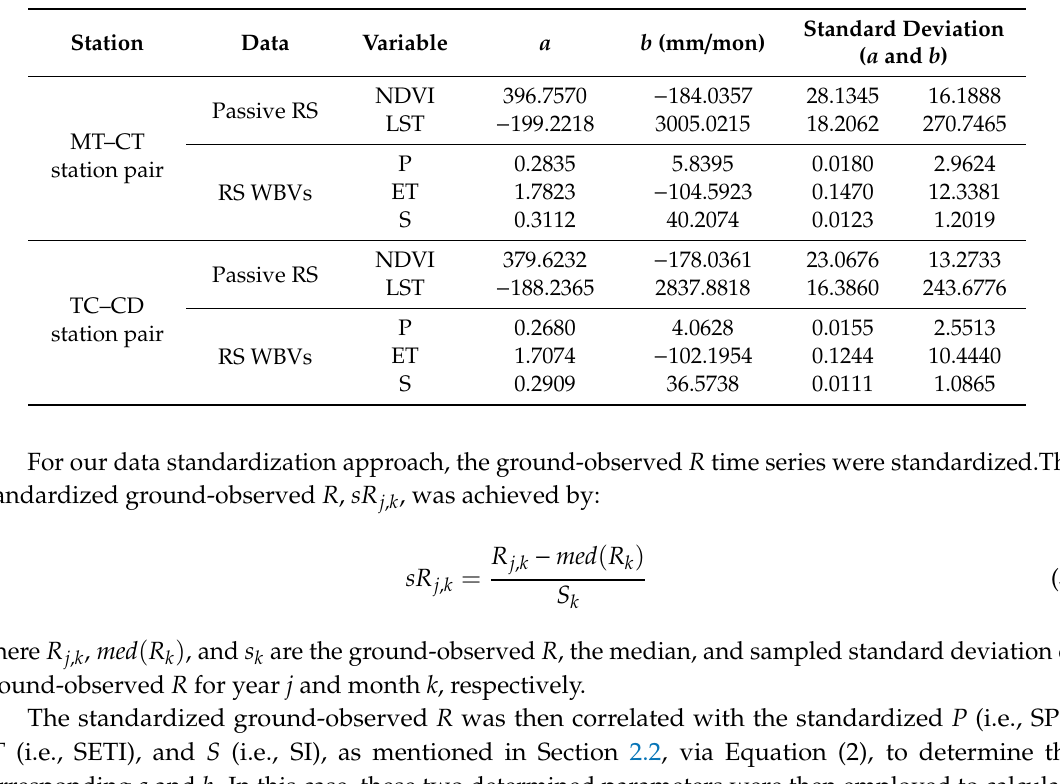
Table2. Runo ff reconstructionparametersbetweentheground-observedruno ff andtheremotely-sensed water balance variables at MT–CT and TC–CD station pairs for the whole upstream area from the Tibetan Plateau to the southern boundary of